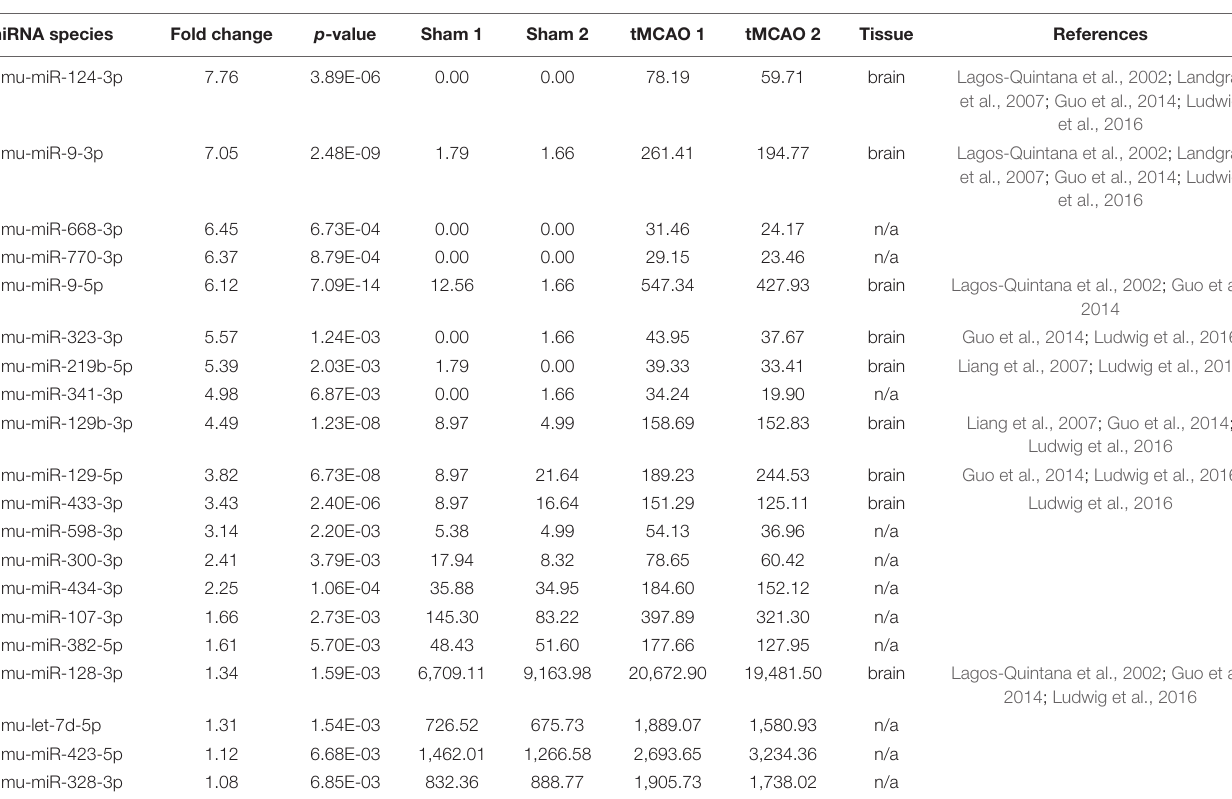
TABLE 3 | List of 20 upregulated serum exosomal miRNAs in tMCAO